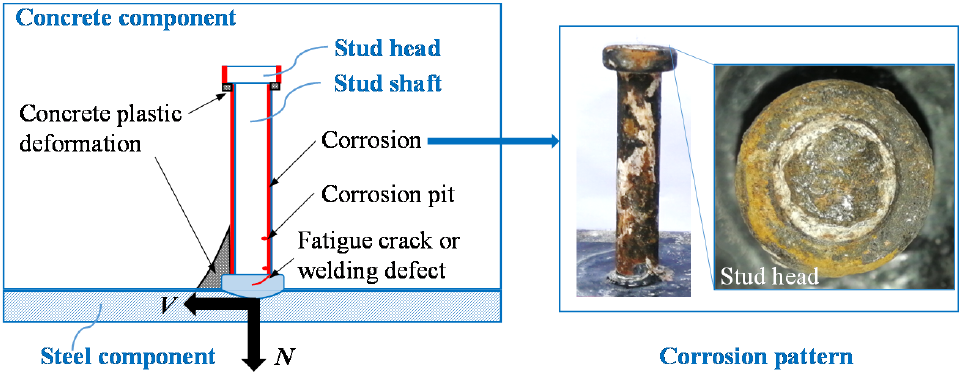
Figure 1. Damage to headed stud shear connectors.